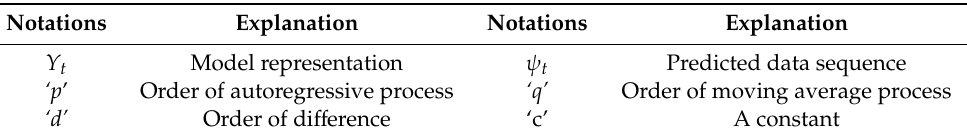
Table 2. Explanation of the symbols in the following